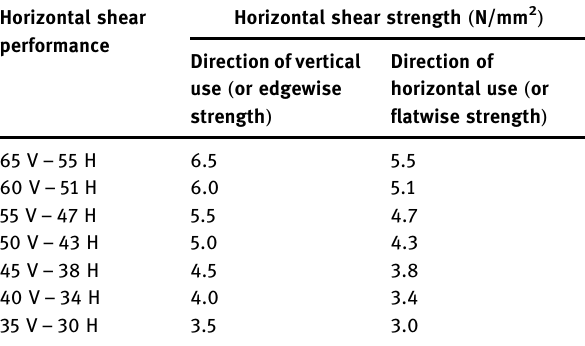
Table 14: Horizontal shear strength performance ( JAS 2008 )